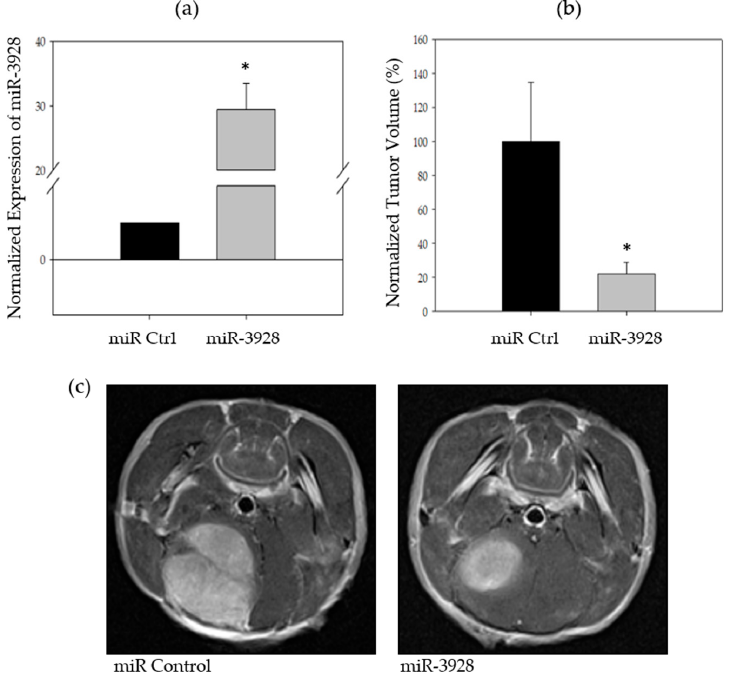
Figure 4. MiR-3928 inhibits in vivo GBM xenograft growth. ( a ) MiR-3928 was stably transfected ex vivo in U87 cell lines. Overexpression of exogenously transfected miR-3928 was confirmed with RT-qPCR. ( b ) A cohort of immunocompromised nude mice were stereotactically implanted with U87 GBM cells expressing either miR-3928 or miRNA scrambled control. The mice were imaged with magnetic resonance imaging (MRI) 16 days post injection. Tumor volumes were measured and averaged. MiR-3928 significantly inhibited tumor growth. ( c ) Representative MRI images of miRNA scrambled control and miR-3928 transfected U87 xenografts. * = p ≤ 0.05.